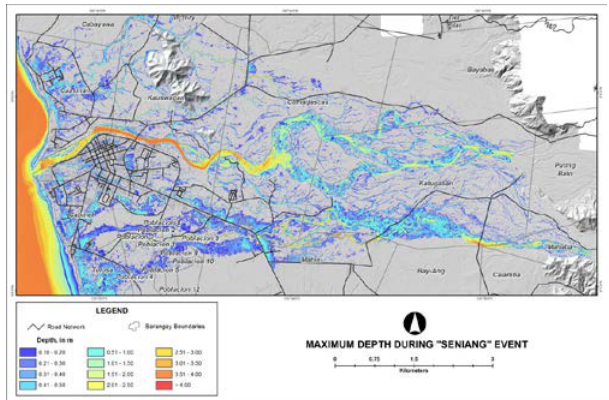
Figure 5. Map showing the maximum flood depths.